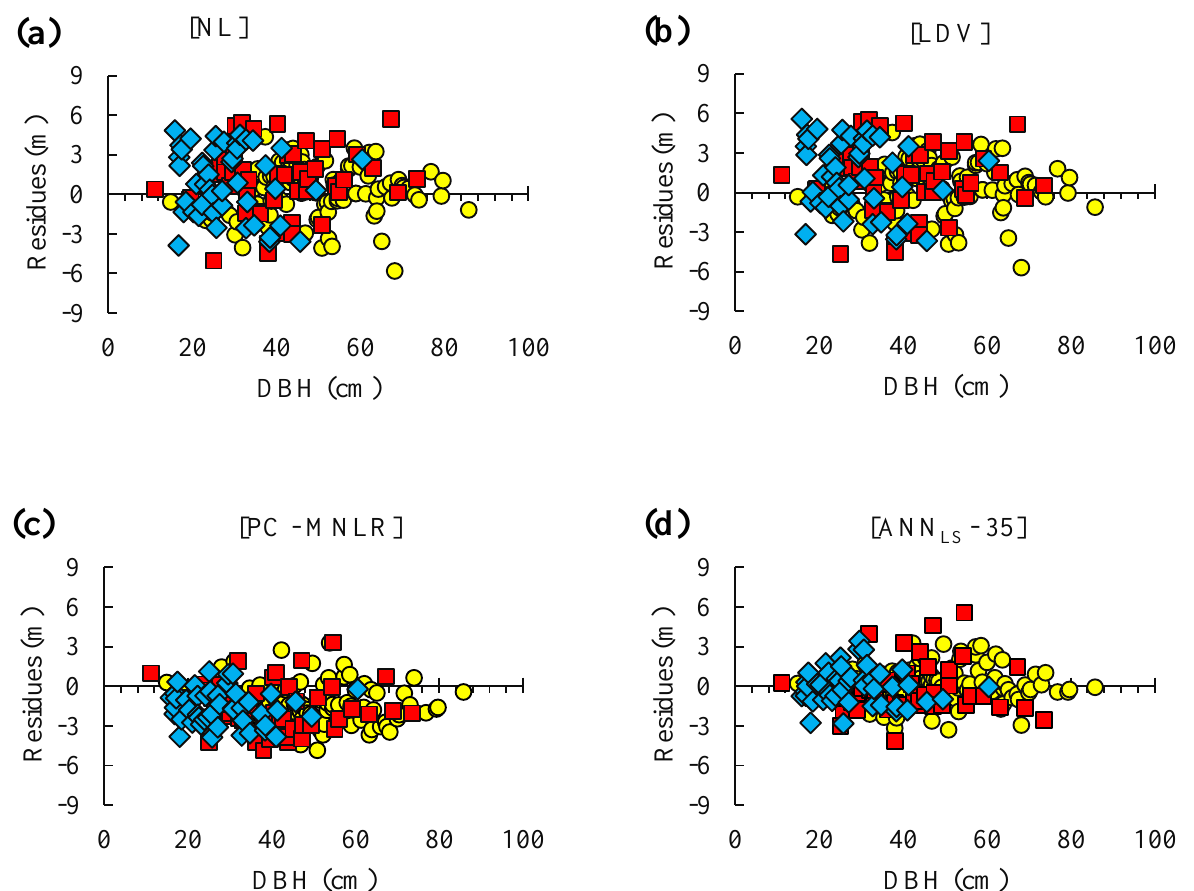
Figure 5. Residual distribution of the four compare methodologies using the validation data for estimating Brazilian pine height. NL: Non-linear ( a ). LDV: Linear with Dummy Variables ( b ). PC-MNLR: Principal Component with Mixed Non-linear Regression ( c ). ANN LS –35: Artificial Neural Networks ( d ). The colors mean the Sociological Position (SP) of the tree in the forest, where: dominant-SP1 (yellow), codominant-SP2 (red), and dominated-SP3 (blue).